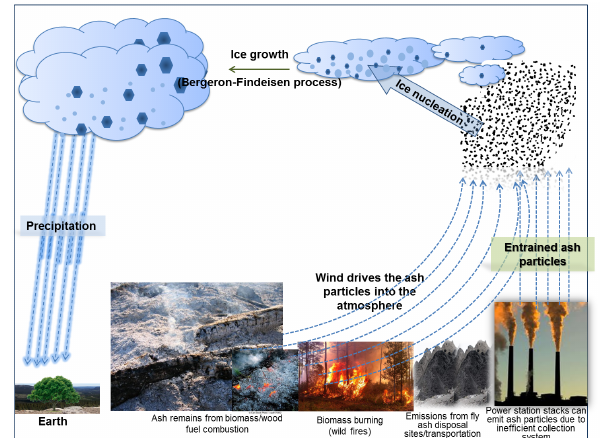
Figure 1. This schematic highlights the possible sources, emission routes and interactions of combustion ash particles in the tropo- sphere. Combustion ash particles also participate in heterogeneous chemistry processes in the atmosphere. This study focuses on their ice nucleation activity at conditions relevant to mixed-phase